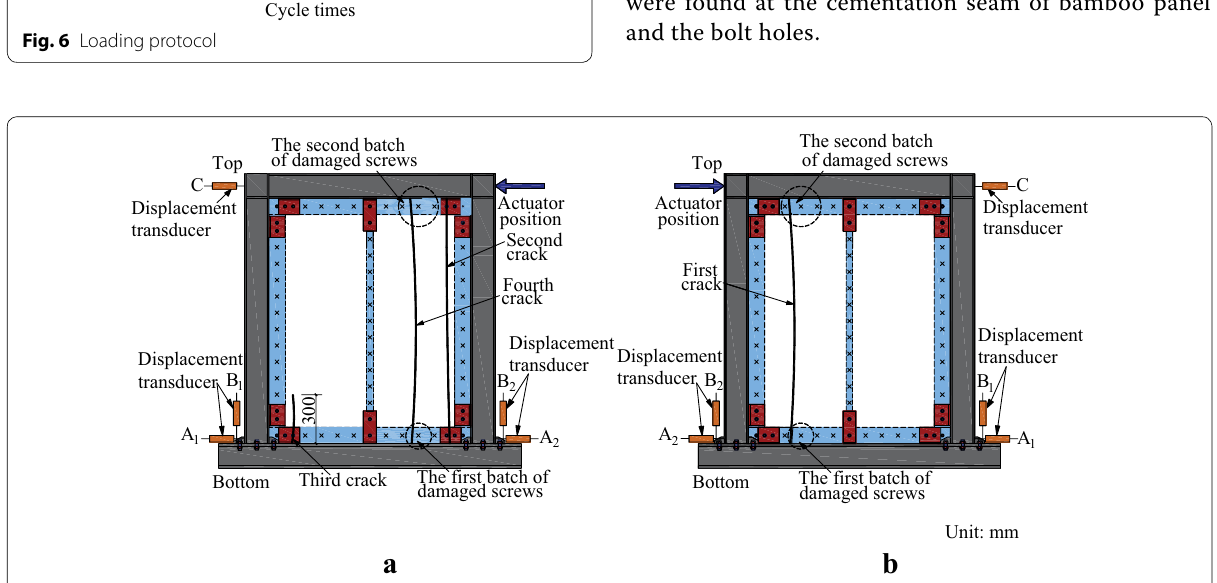
Fig. 6 Loading protocol